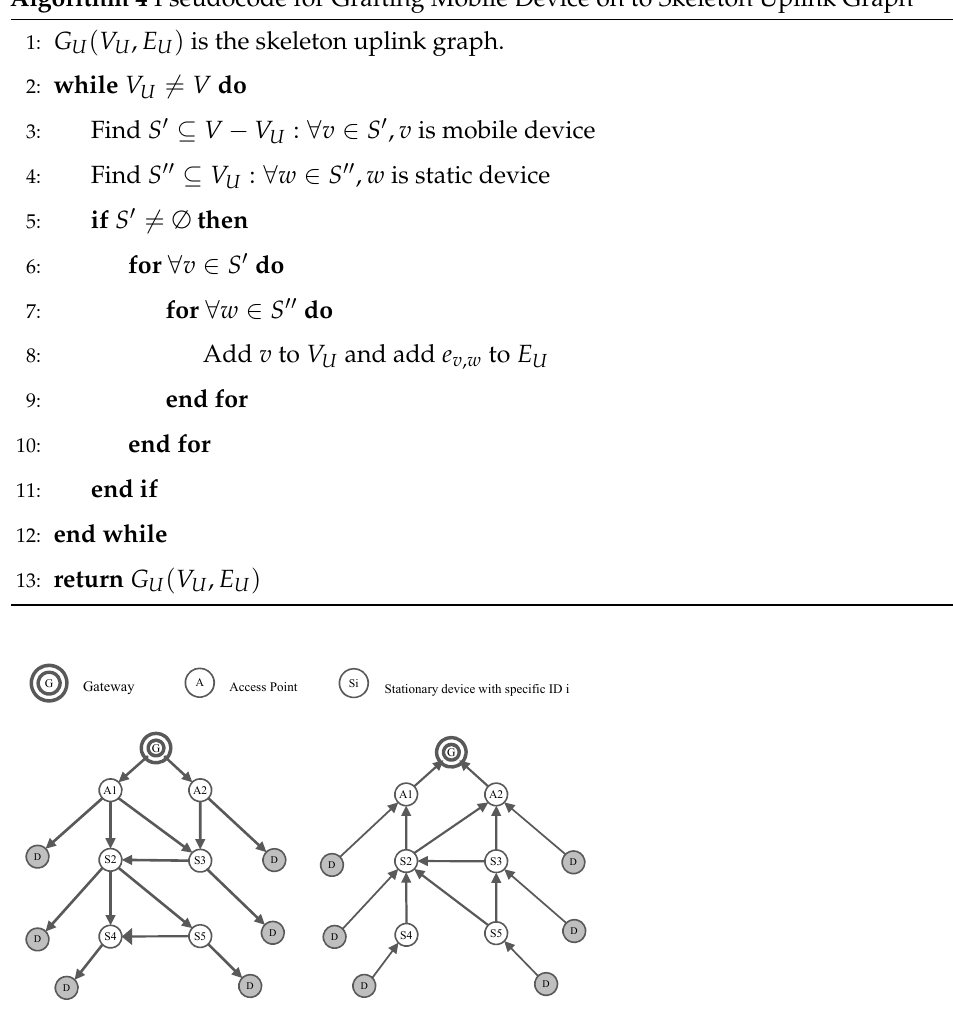
Algorithm 4 Pseudocode for Grafting Mobile Device on to Skeleton Uplink Graph